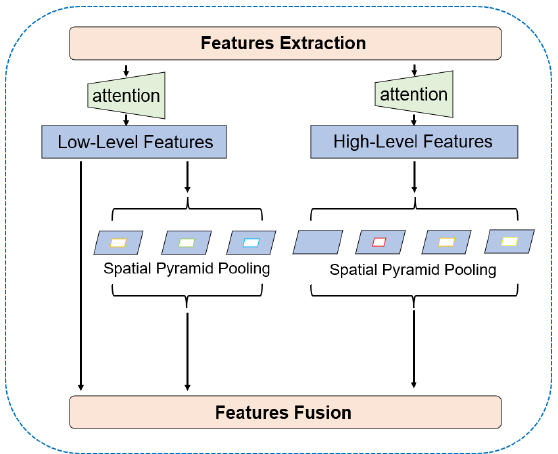
Figure 6. The dimensional change graph of the original DRN ( left ) and the SE-DRN module ( right ).